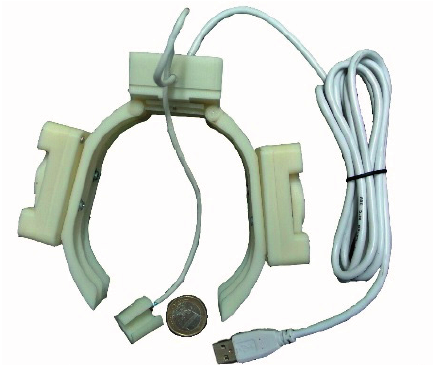
Figure 5. Prototype implementation of the assessment system (glove part) for parkinsonian motor symptoms. In addition to tremor assessment, this modified version of the assessment system can be used to assess bradykinesia, dyskinesia, and